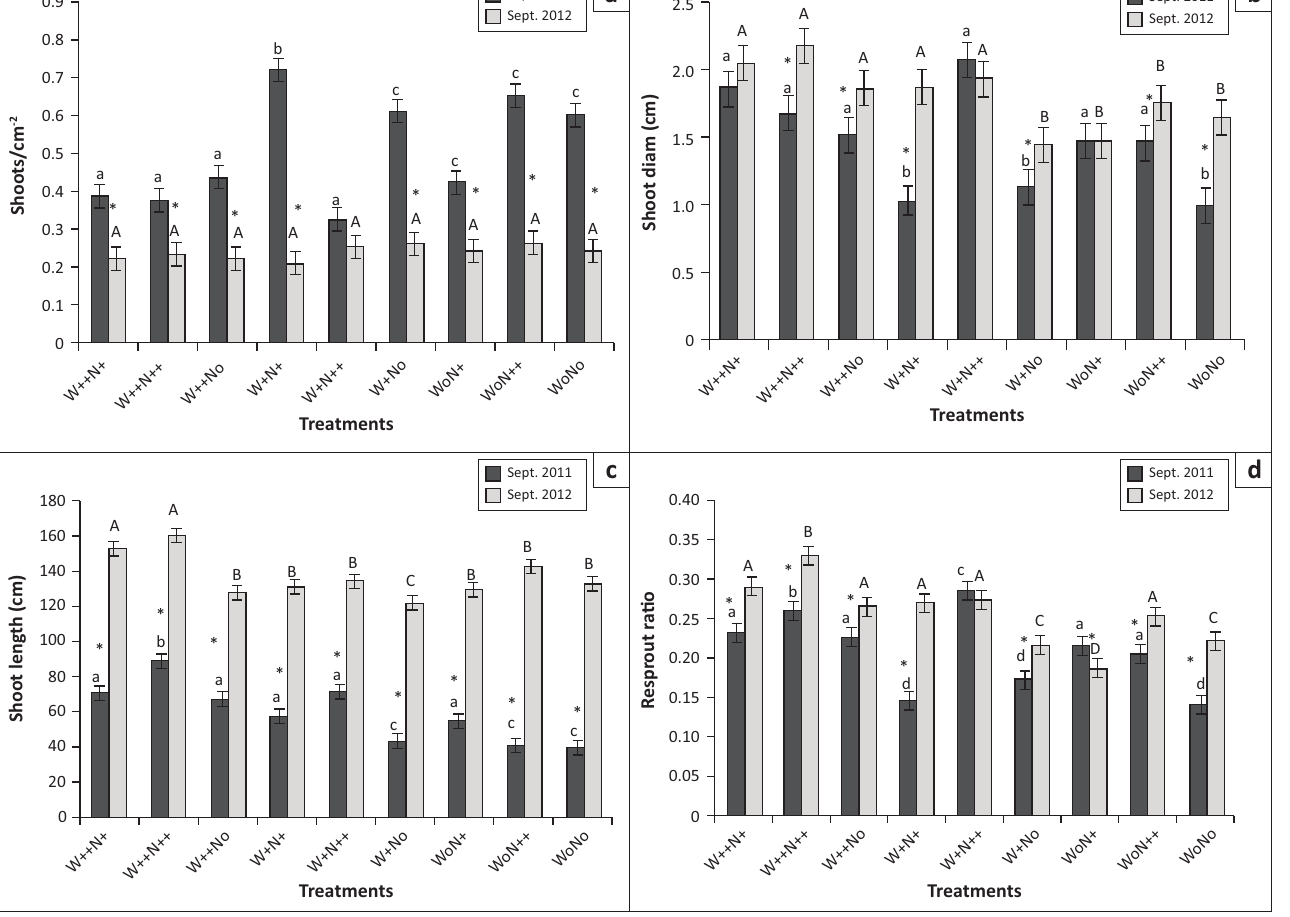
The means are represented with standard error bars. W, water treatment; N, nutrient addition. FIGURE 4: Effects of water and nutrient interaction on (a) shoot production (calculated as the number of shoots per unit area of original stump circumference cm 2 ), (b) shoot diameter, (c) shoot length and (d) resprout ratio (calculated as the ratio of the tree’s original stump diameter to that of the leader shoot resprout diameter) between September 2011 and September